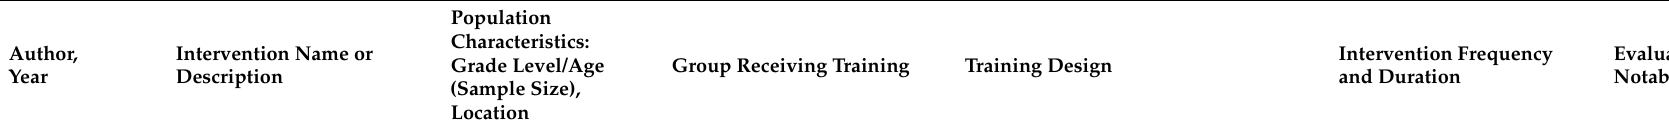
Table 7. Group F: Community, afterschool or extracurricular interventions that trained same-age